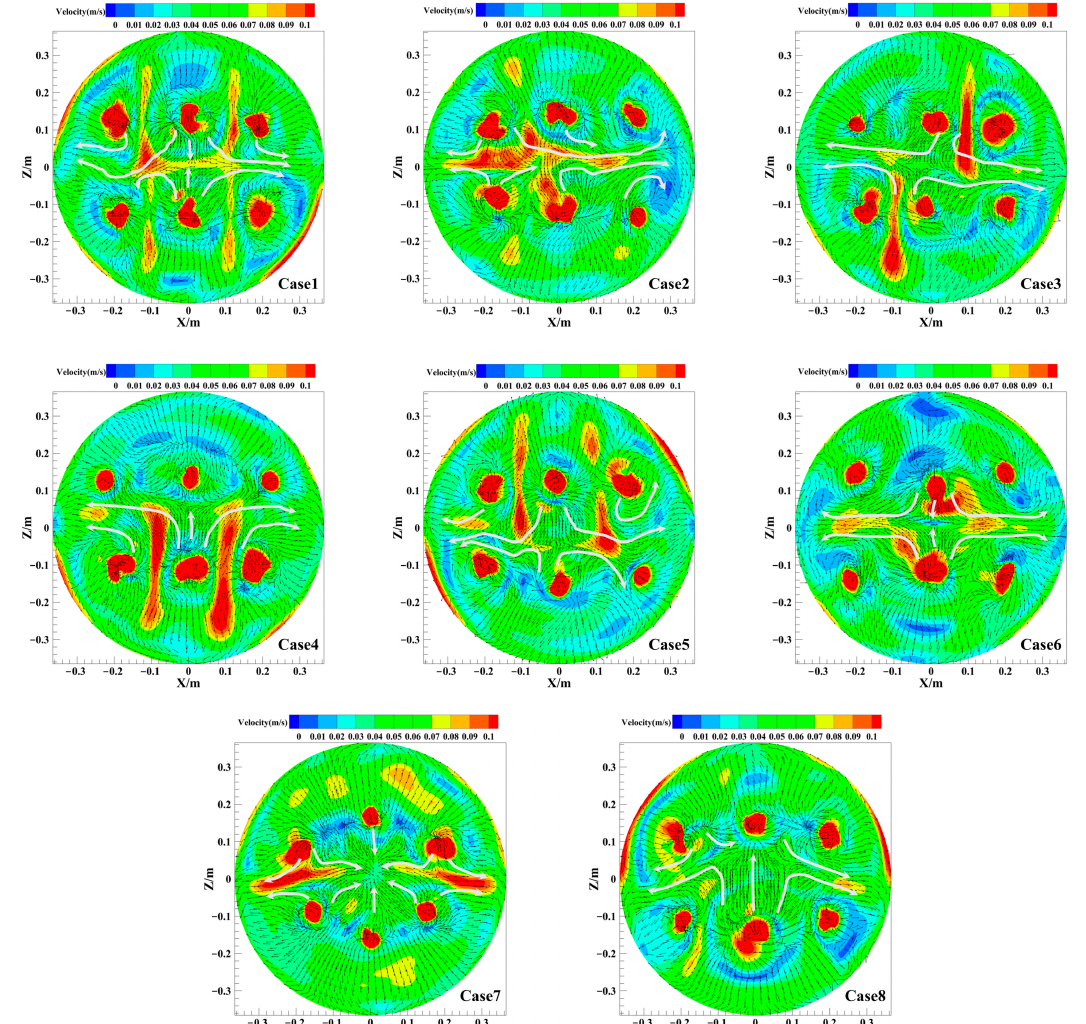
Figure 5. Effect of bottom blowing mode on the flow field of molten bath in the eight